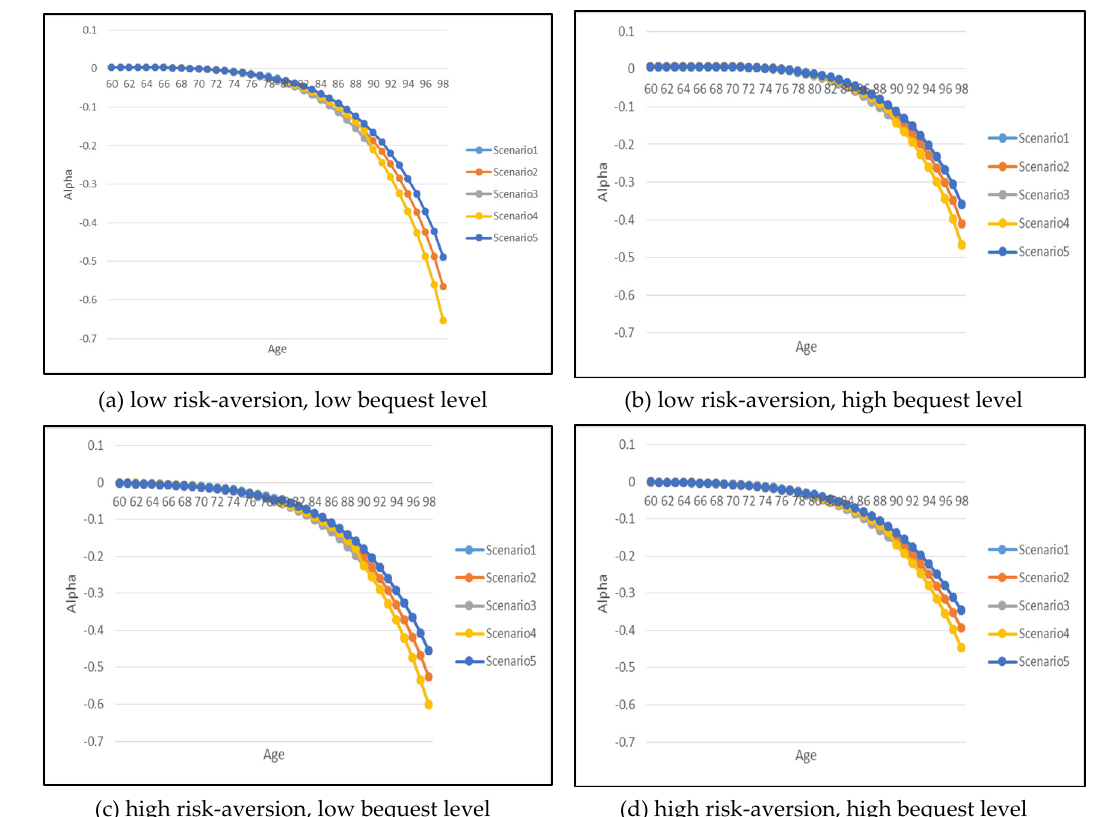
Figure 6. Optimal Annuity/Insurance Purchase for Males (Health-Independent Utility).